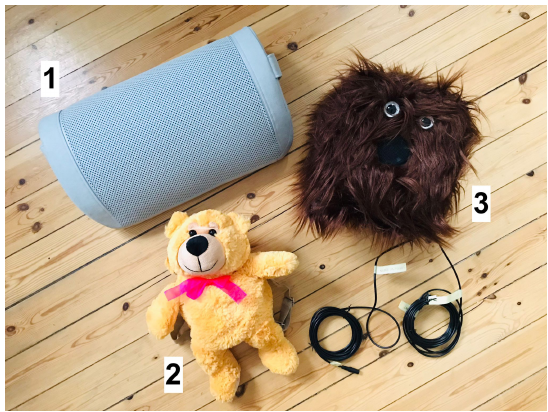
Figure 3. The Haptic Music Players (HMPs) used in the study: HMP (1) a haptic pillow, HMP (2) a plush toy backpack with an embedded haptic strap, and HMP (3) a custom-built plush toy with an embedded tactile transducer and full-range